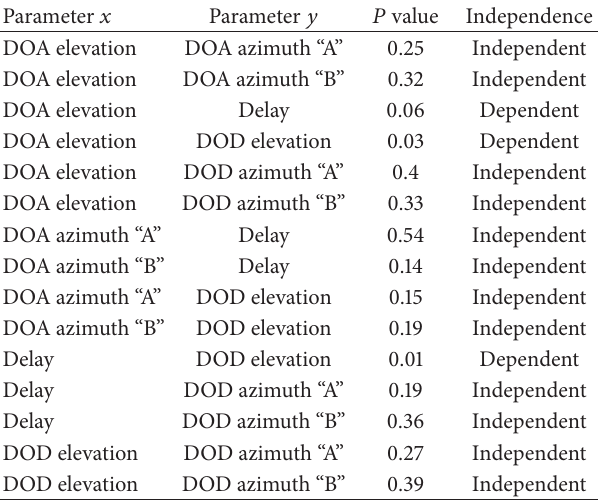
Table 4: 𝑃 value of LSIT of channel